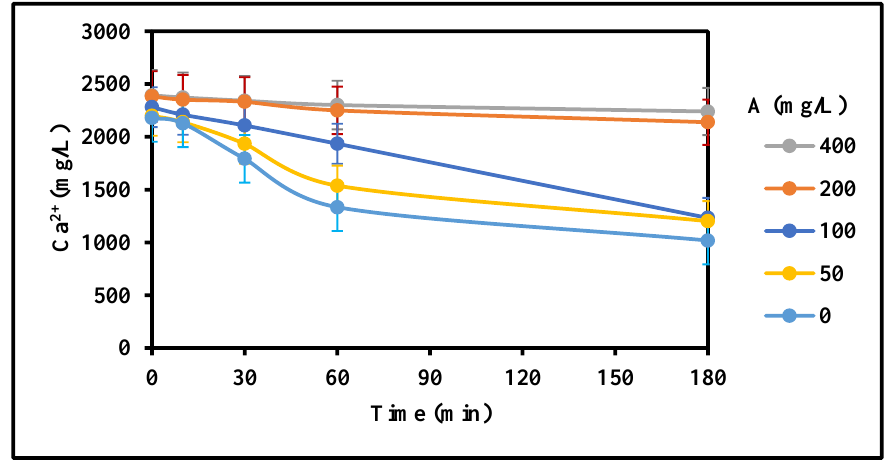
time (min): 180/180; CaCO 3 addition: Time 0 to 10 min). Stirring time (min): 180/180; CaCO 3 addition period: 10 min).